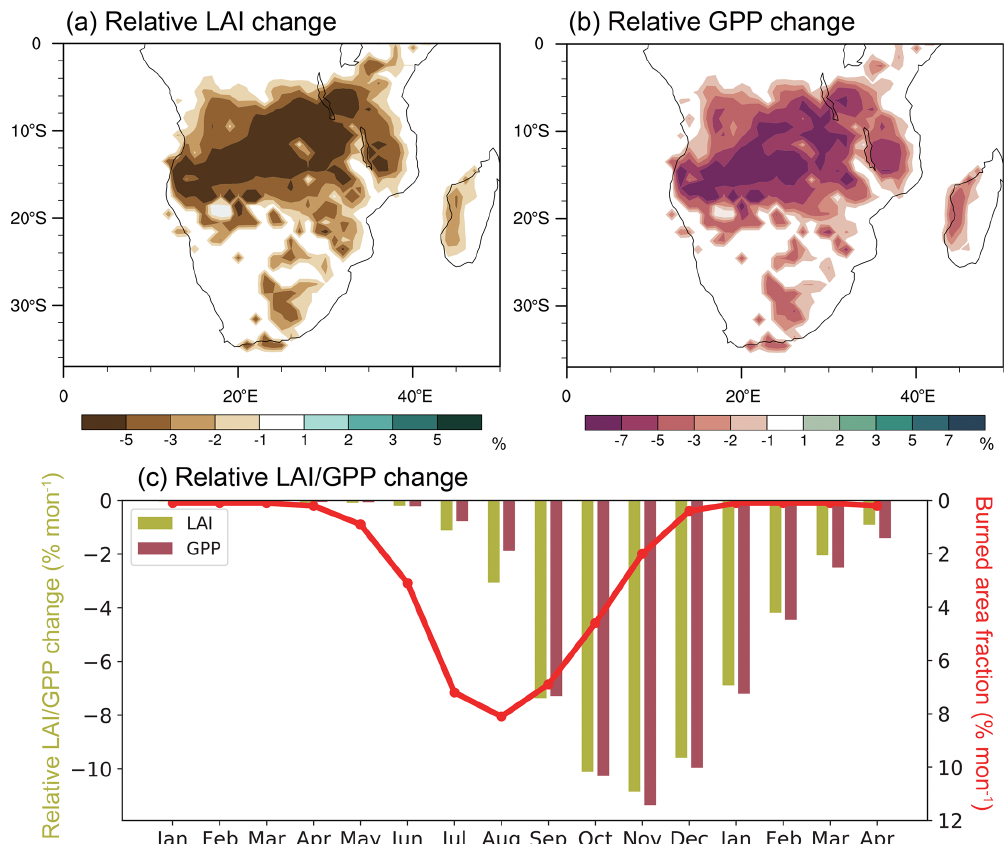
Figure 8. 2000–2013 annual fire effects on (a) LAI (%) and (b) GPP (%), and (c) monthly fire effects on the LAI/GPP (%month − 1 ) with burned area fraction (%month − 1 ) overlaid (the areal-average fire effect is calculated using grids with an annual burned area fraction > 10%). The y axis of burned fraction in panel (c) is